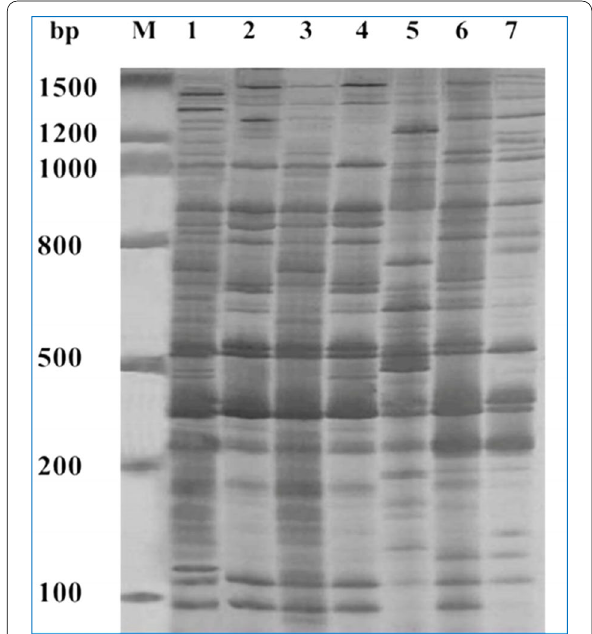
Fig. 3 AFLP amplification profile generated from genomic DNA of six Dimocarpus longan regenerated plants and its doner plant. M: marker, Lane 1: doner plant. Lane (2–7): in vitro regenerated plants